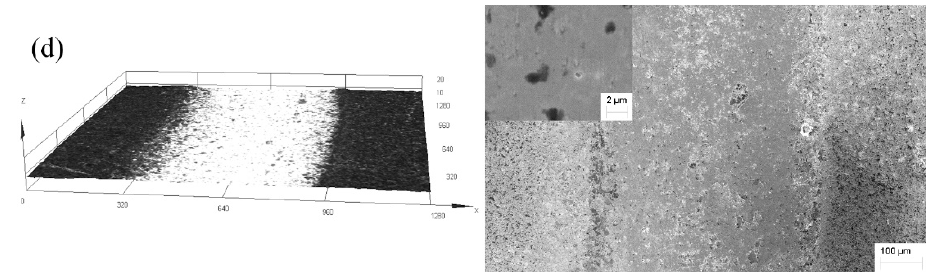
Figure 8. SEM and 3-dimensional micrographs show the wear morphology of the samples. (a) sample 1, Pristine (b) sample 2, 2 × 10 17 (c) sample 3, 5 × 10 17 (d) sample 4, 1 × 10 18 .